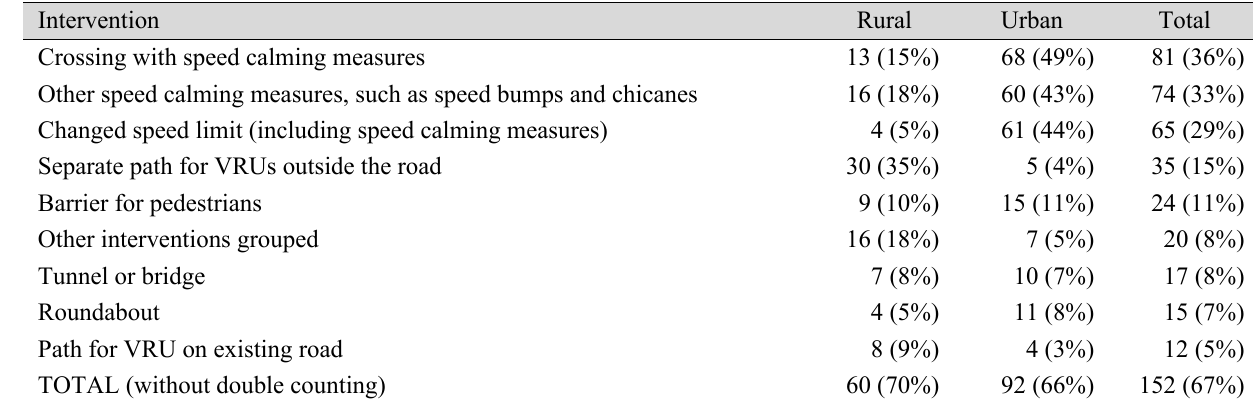
Table 2 Potentials of infrastructure interventions to prevent pedestrian fatalities Intervention Rural Urban